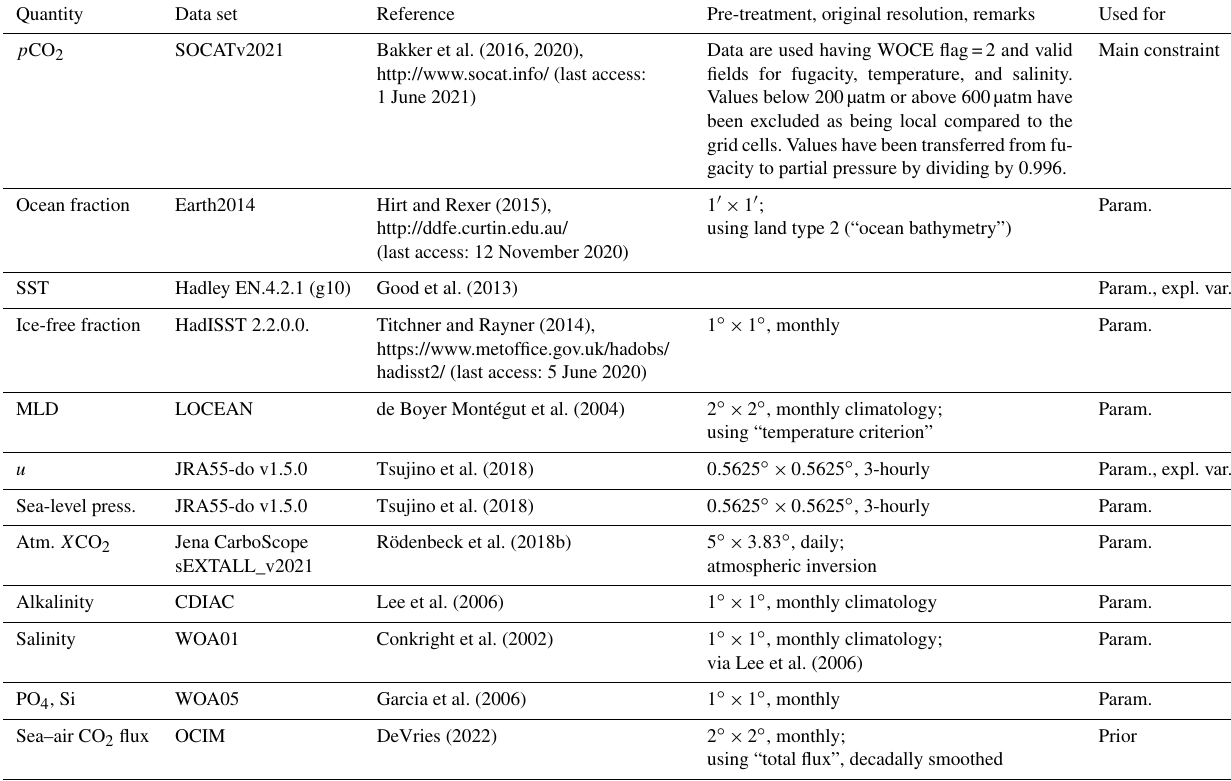
Table 1. Input data